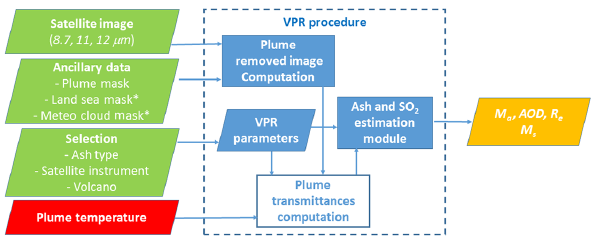
Figure 1. VPR I/O flowchart. Green: inputs given for a specific pro- cessing (the asterisk means optional input). Red: input to be com- puted. Orange: